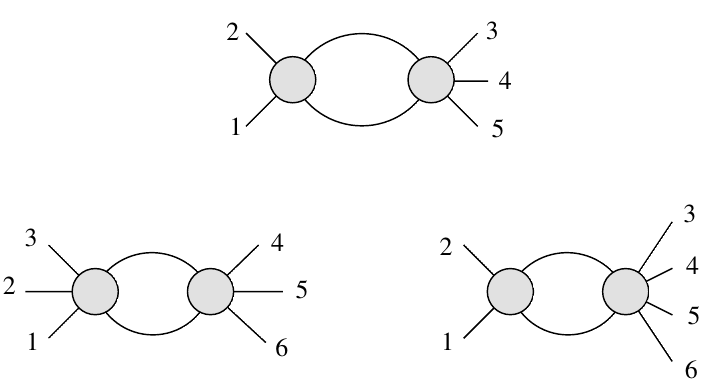
Figure 2 . The Feynman diagrams contributing to five and six-point amplitudes in conformal DBI at one loop of order s 4 at D = 4 and s 5 at D = 6, where the four-point vertex is identical to that of DBI, and five- and six-point vertices are φ ( ∂φ · ∂φ ) 2 and φ 2 ( ∂φ · ∂φ ) 2 . One should also sum over all other independent